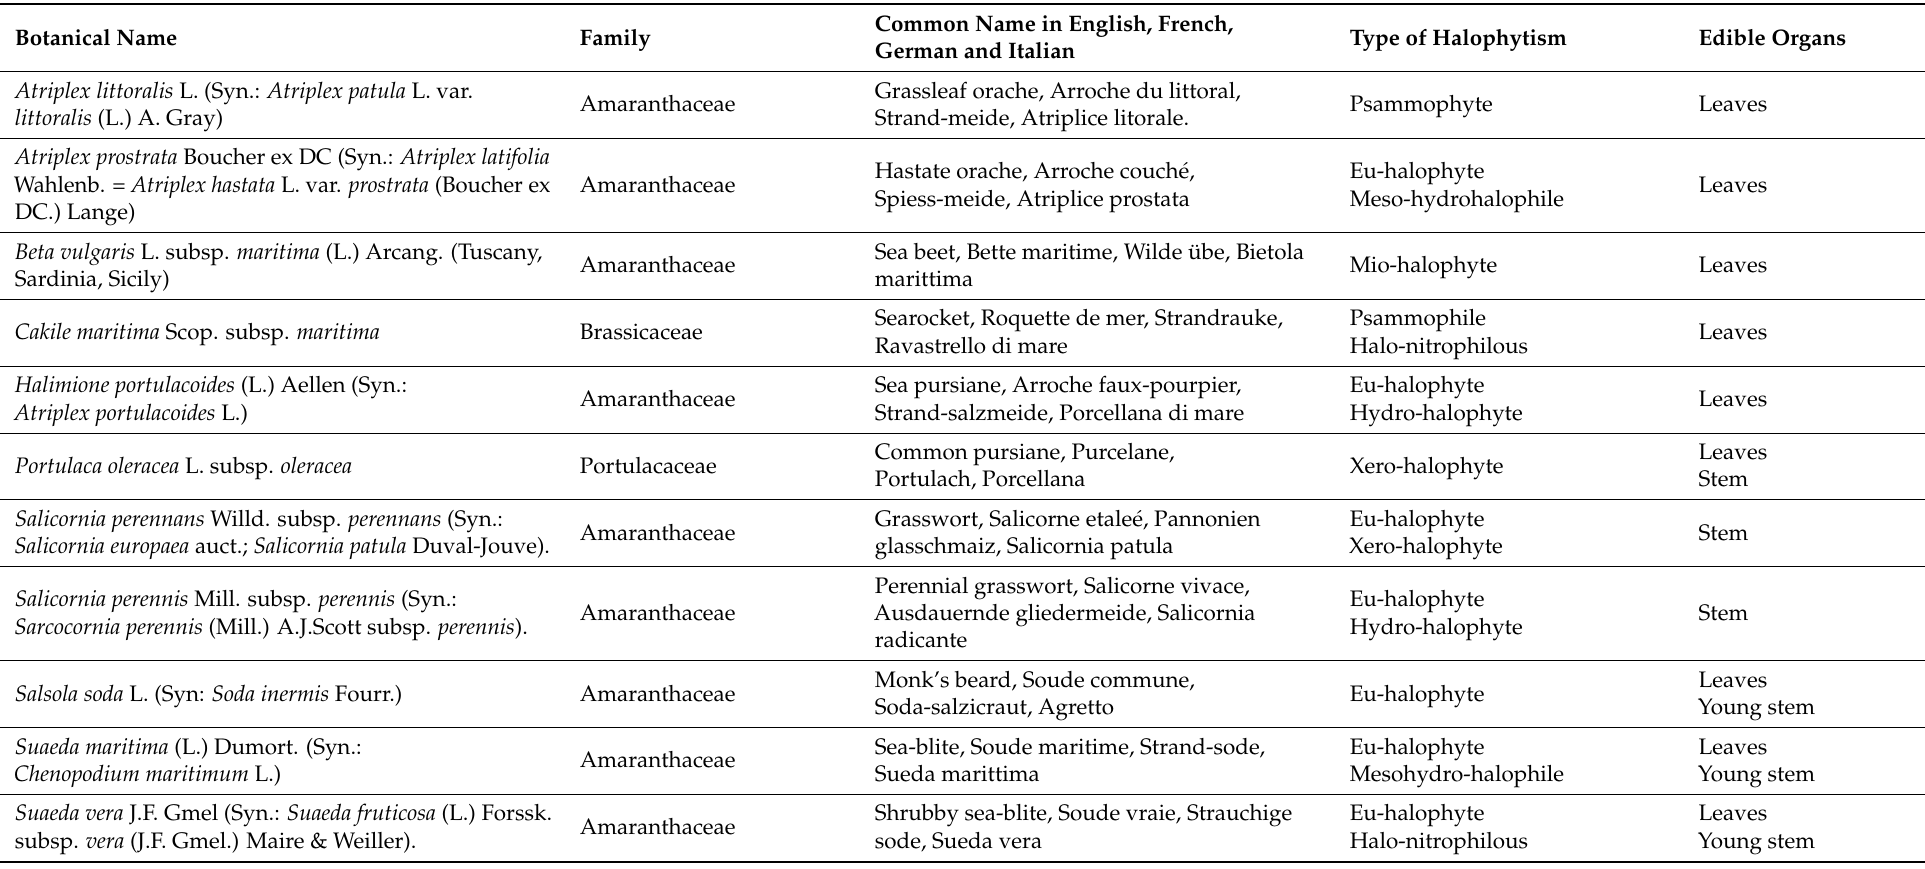
Table 1. List of halophytes selected on the basis of their diffusion in the Mediterranean region and their type of halophytism according to eHALOPH